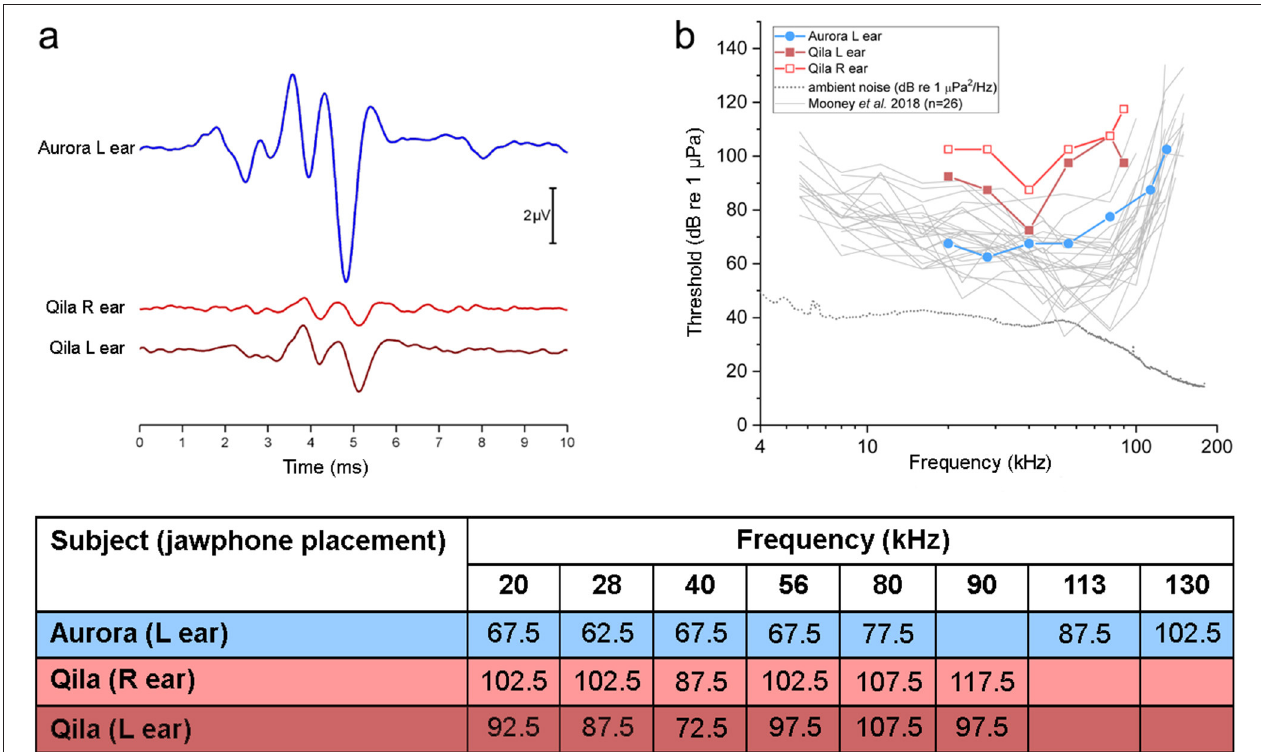
FIGURE 1 | (a) Click-evoked auditory brainstem responses (ABRs) measured for the 40-year-old beluga Aurora (blue) and 21-year-old Qila (red). ABRs from Aurora were of relatively large amplitude. In contrast, ABRs from both ears from Qila had smaller amplitude, with increased latencies of the dominant waves. (b) Auditory evoked potential audiograms measured in Aurora (left ear, blue circle) and Qila (left ear, red closed squares; right ear, red open squares), in comparison with those reported by Mooney et al. (25) for 26 belugas. Underwater ambient noise levels (power spectral density, units of 1 µ Pa 2 /Hz) for the pool in which Aurora and Qila were tested are shown with a dotted line. Note that Qila has a hearing loss which is most apparent in the high frequencies at 56kHz and above (see table) and in the right ear (light red). Table in (b) AEP hearing thresholds (in dB re 1 µ Pa) for Aurora and Qila tested in March 2014. Hearing threshold was defined as the mid-point between the lowest stimulus level for which a statistically significant response was detected, and the highest level for which no AEP was detected. R, right; L,